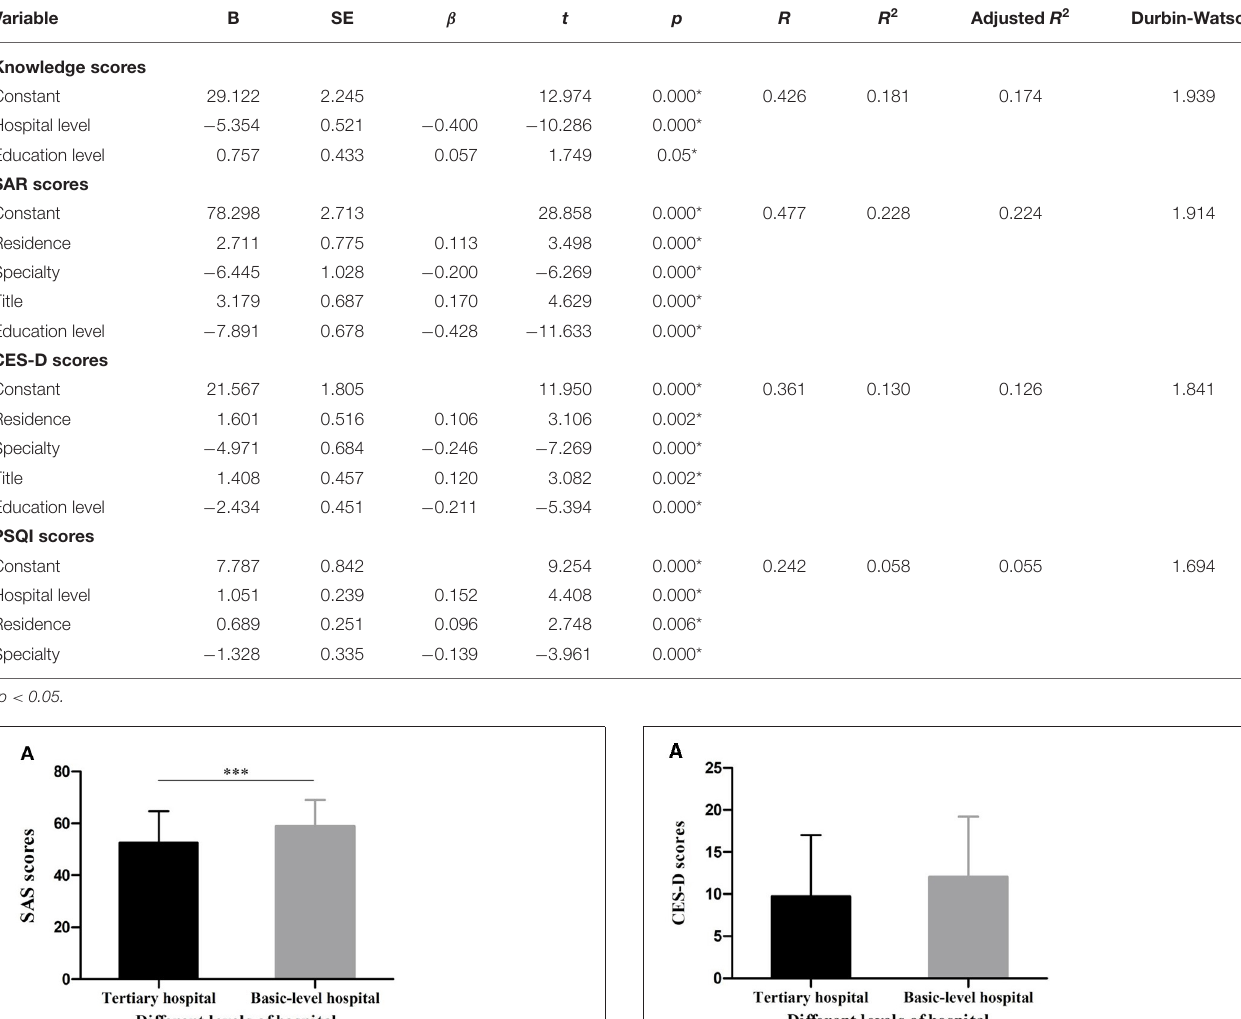
TABLE 3 | Results of multivariate analysis in mental status of medical staff.